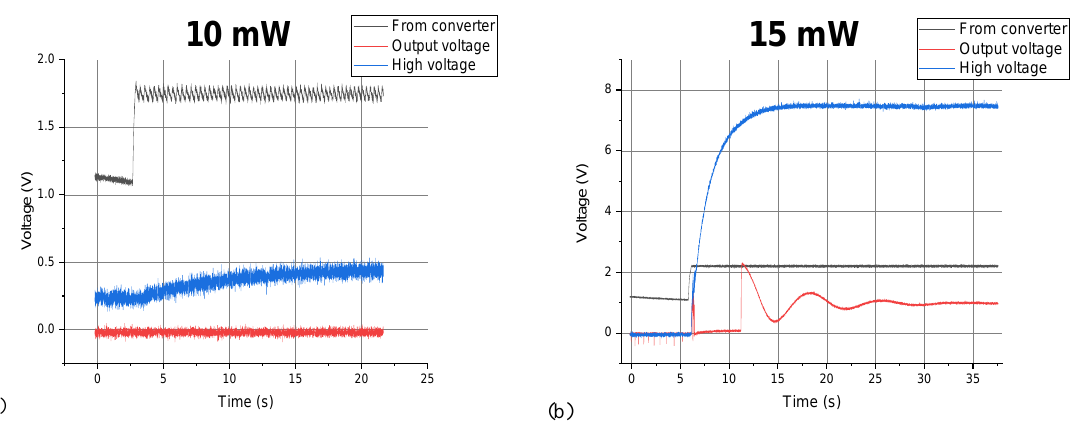
Figure 3. Experimental demonstration of power supply of the system for stabilizing the operating point from radiation at a wavelength of 1550 nm: ( a ) system fails to start at an input optical power of 10 mW, ( b ) normal operation of the system at an input optical power of 15 mW.